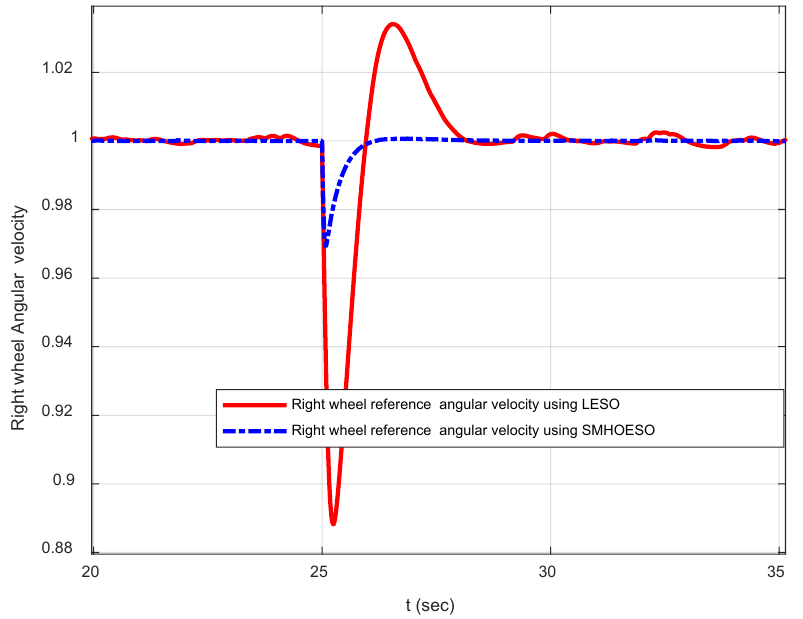
Figure 9. Comparison between the proposed SMHOESO and the conventional LESO.